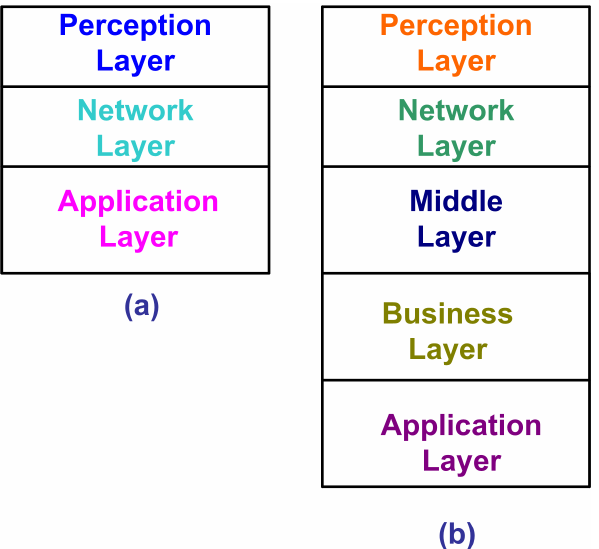
Figure 3. ( a ) Three-Layer Architecture; ( b ) Five-Layer